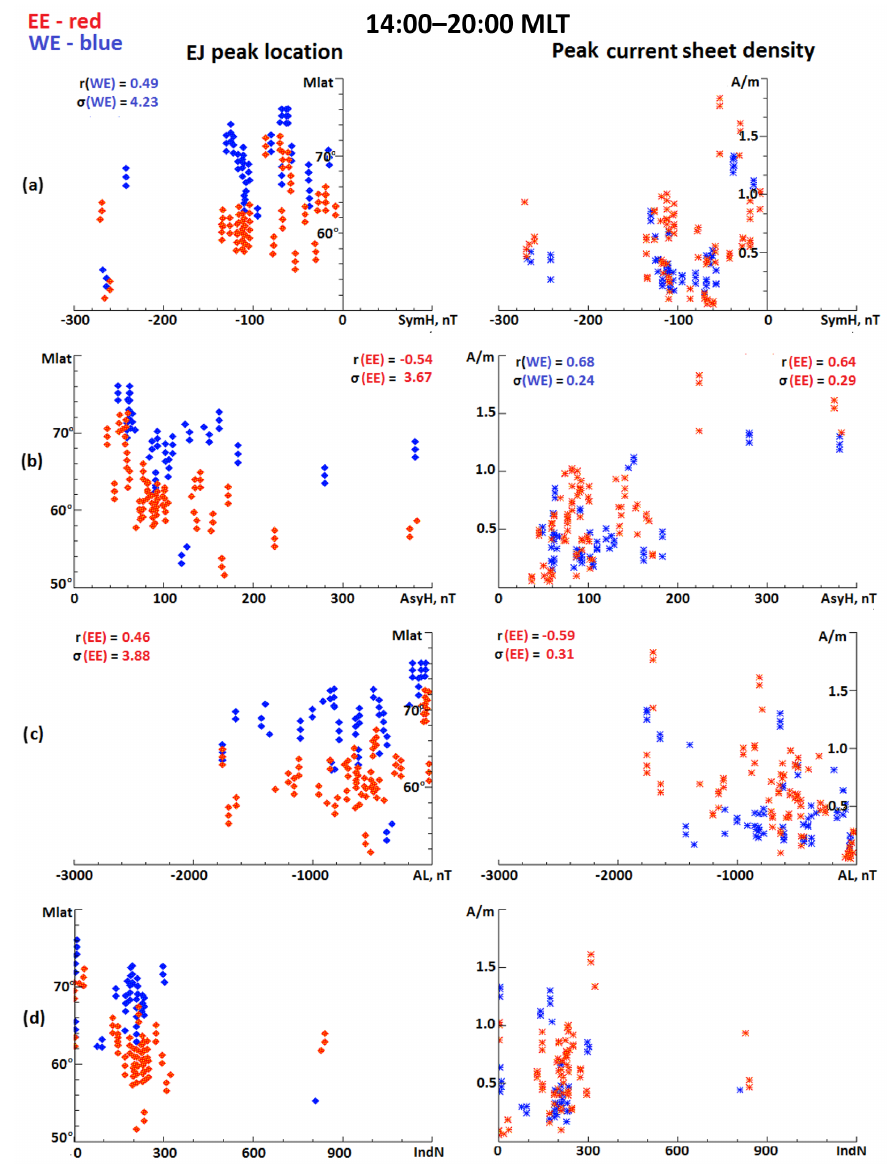
Figure 5. The same as in Fig. 4, but for the evening sector